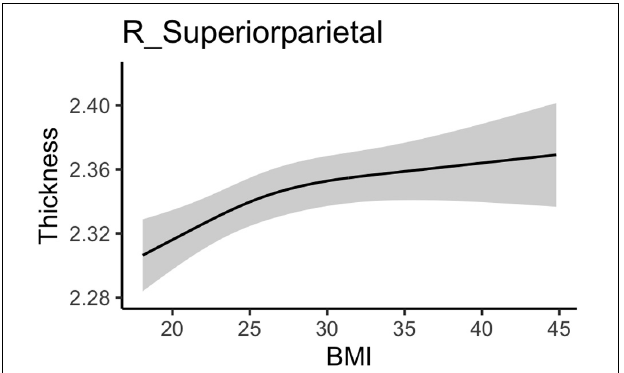
FIGURE 3 | Association between body mass index and gray matter thickness values.